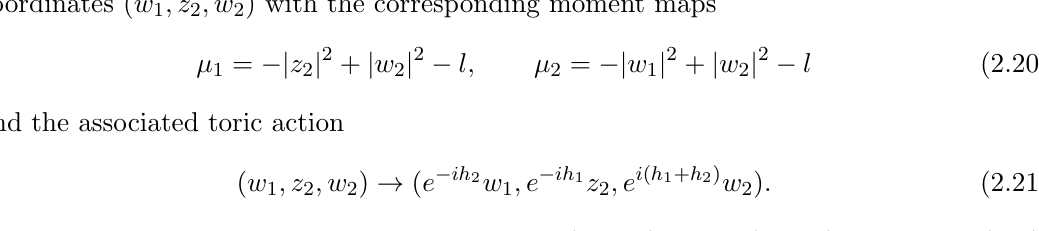
Figure 5. A colored ( p; q )-web specifying divisor of x N 3 y N 2 w N 1 in CY 3